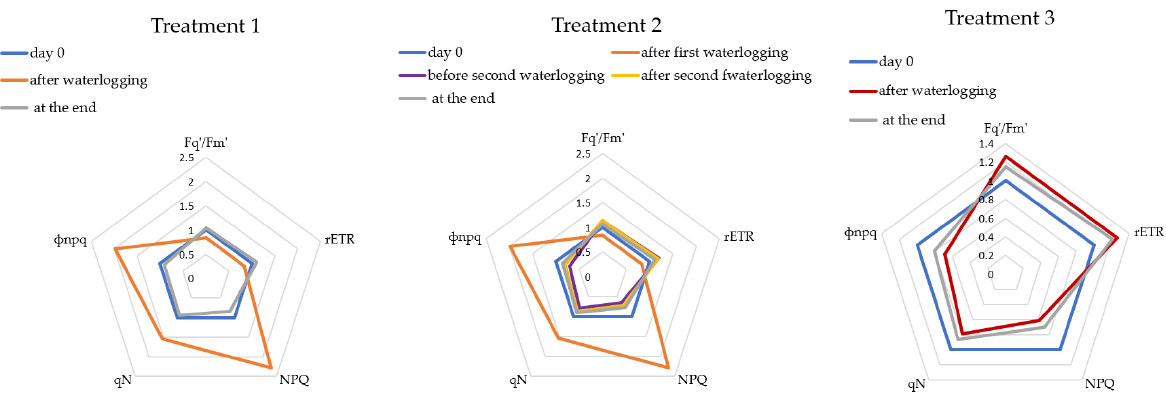
Figure 3. Spider plots obtained from photosynthetic measurements measured in 3 different treatments. Treatment 1 ( A ), Treatment 2 ( B ), Treatment 3 ( C ). All values shown are percentages of values obtained for control plants, enabling comparison of the variables measured on different scales. Table 5. Changes in molecular stress parameters under